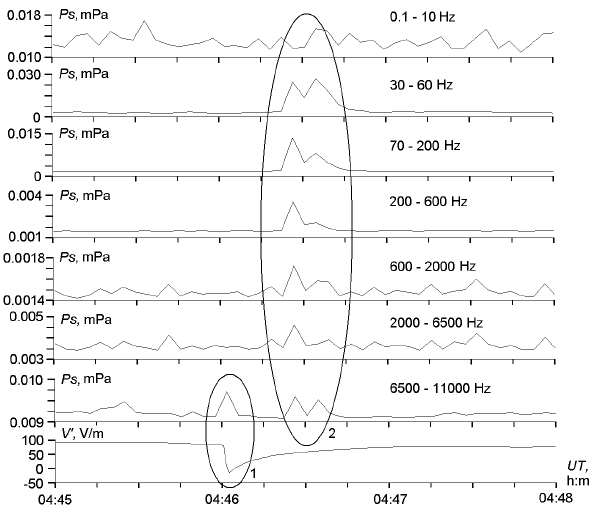
Fig. 5. Acoustic emission plots in seven frequency ranges and potential gradient of electric field intensity in the near-ground air (in the bottom) during the lightning discharge on October 2, 2008. Acoustic emission response registered in the experiment corresponds to the results of laboratory and natural tests described above. As long as the response is observed only in the range of 6.5-11 kHz, we may suggest characteristic size of sources of 10 -1 m. Evaluation was carried on the basis of signal propagation in sedimentary rocks according to Brune formula [Brune, 1970]. It is one order as much as in the laboratory tests and 4 orders less than natural tests; similar effects have not been observed on such scales before. In this case the increase of acoustic emission activity under the influence of electric impulse has been registered for the first time in natural conditions during lightning discharge. Lightning discharge energy was estimated to be 10 9 – 10 10 J according to the paper [Rakov and Uman, 2003]. Assuming that energy fall occurs according to the law of 1/r 2 , we may evaluate its value at the